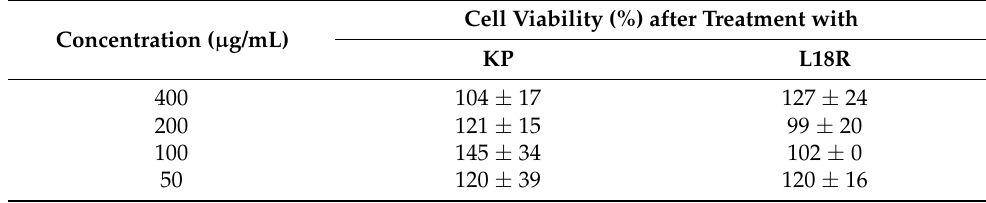
Table 1. In vitro cytotoxic activity of the investigated peptides against L929 cells.